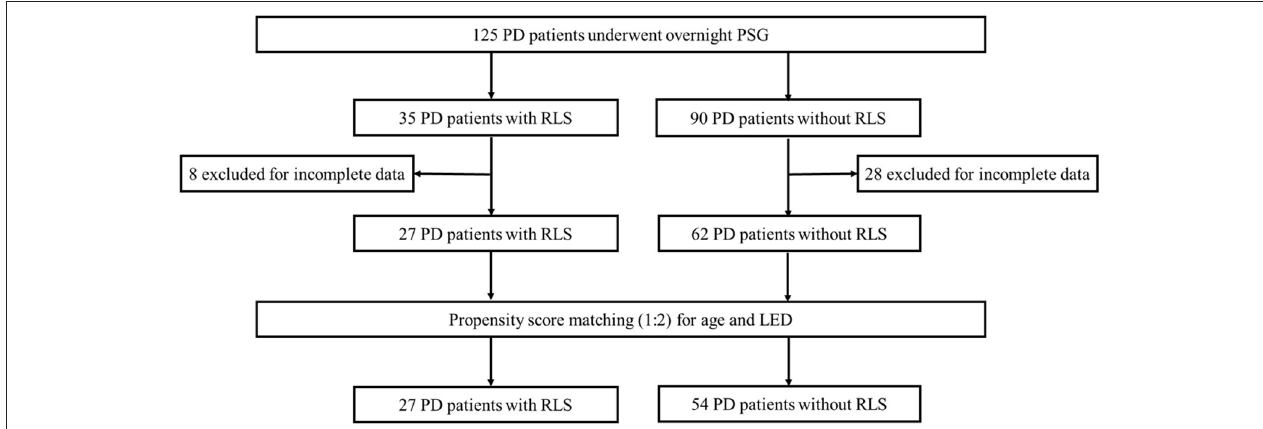
FIGURE 1 | Flow chart diagram of the selection of PD patients included in the analyses. PD, Parkinson’s disease; PSG, polysomnography; RLS, restless legs syndrome; LED, levodopa equivalent dose.